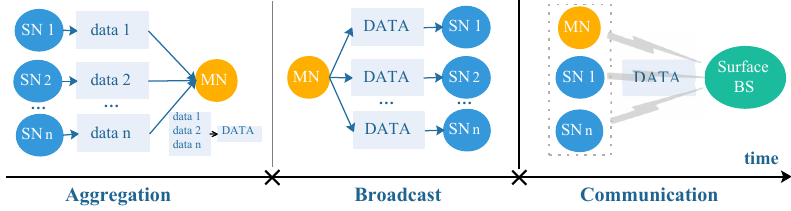
Figure 3. The process diagram of the Steady-state